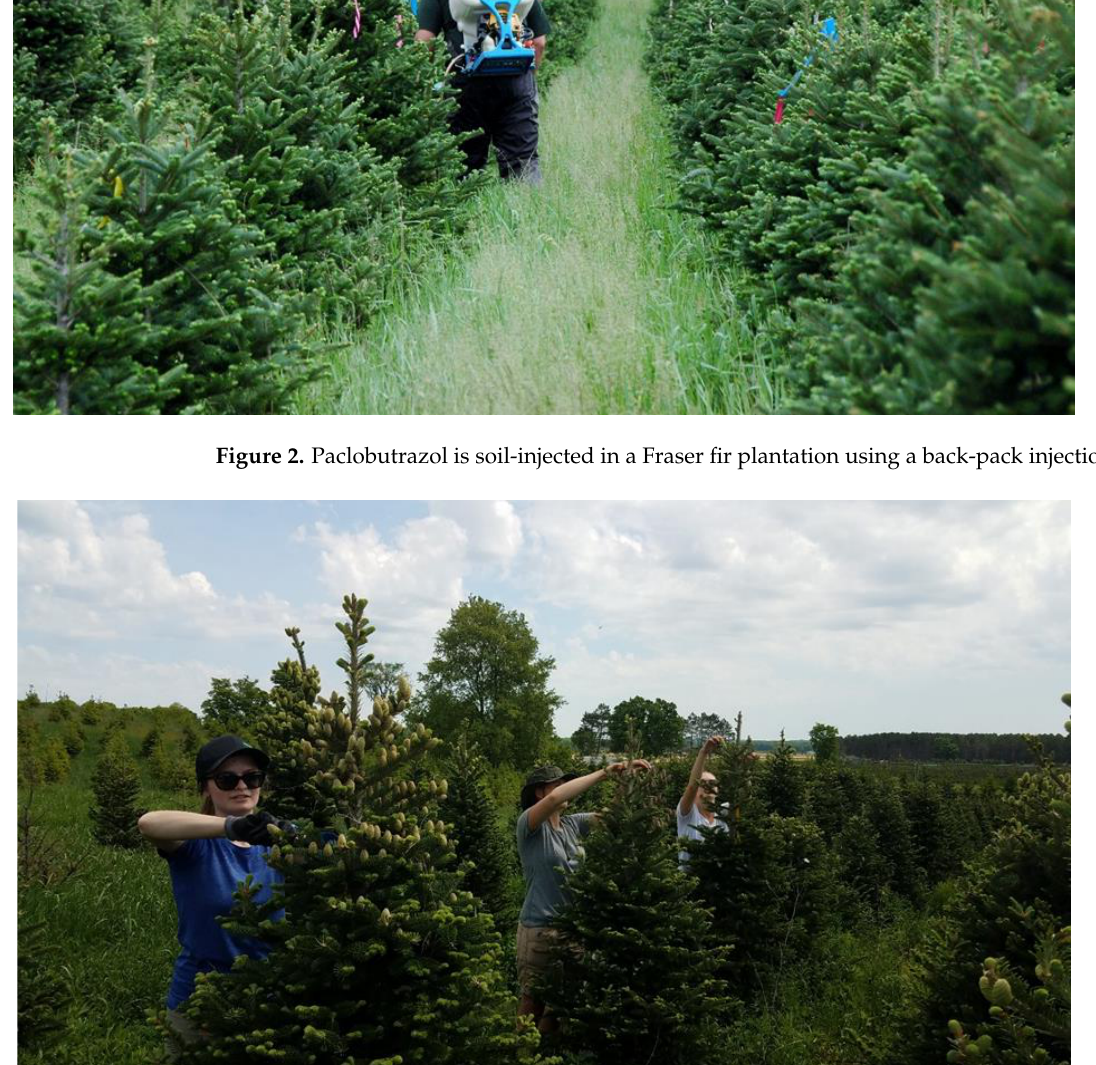
Figure 2. Paclobutrazol is soil-injected in a Fraser fir plantation using a back-pack injection system.